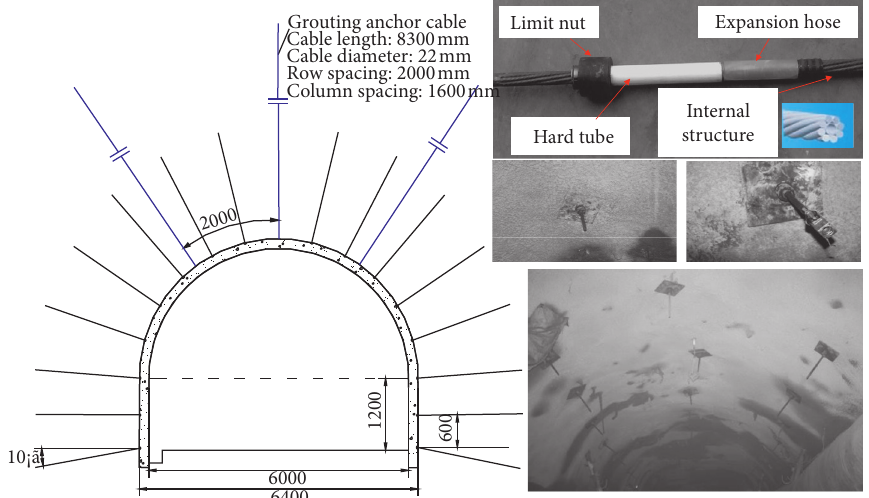
Figure 7: Parameters and effect of grouting reinforcement.